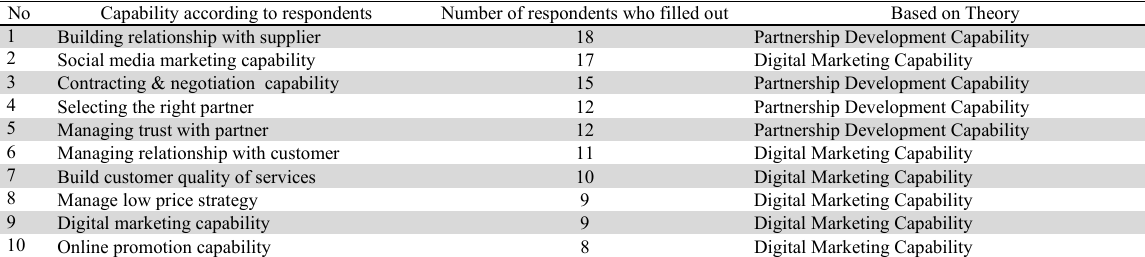
Fig. 1. Online Business Performance of Women Entrepreneur in Indonesia Table 1 Key Success Factor of Online Woman Entrepreneur No Capability according to respondents Number of respondents who filled